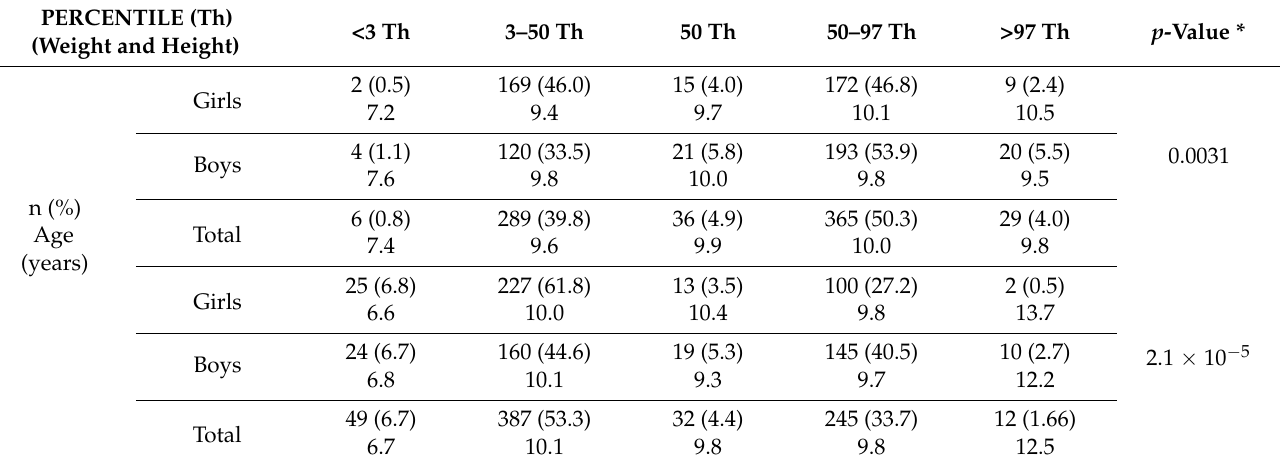
Table 2. Contingency table of the different percentiles based on weight and height, sex, and age in years of the sample.